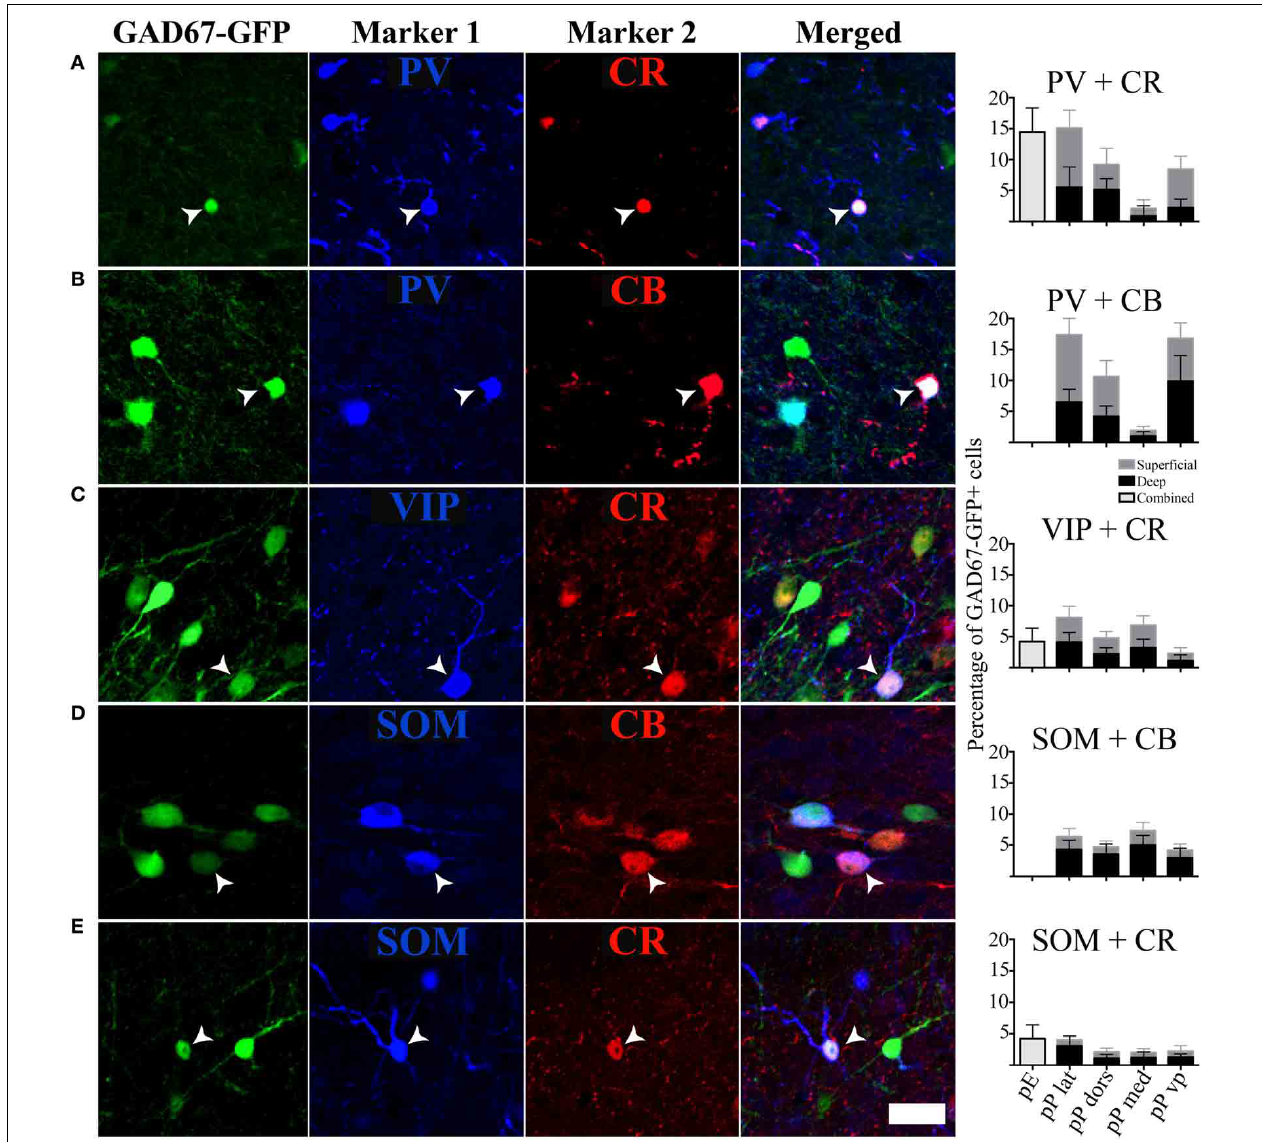
FIGURE 4 | Specific pairs of antigens colocalize with GAD67. (A–E) Photomicrographs of the GAD67-GFP cells stained for an additional two markers. White arrows point to cells with triple colocalization. Far right column: quantification of the percentage of GAD67 cells colocalized with the